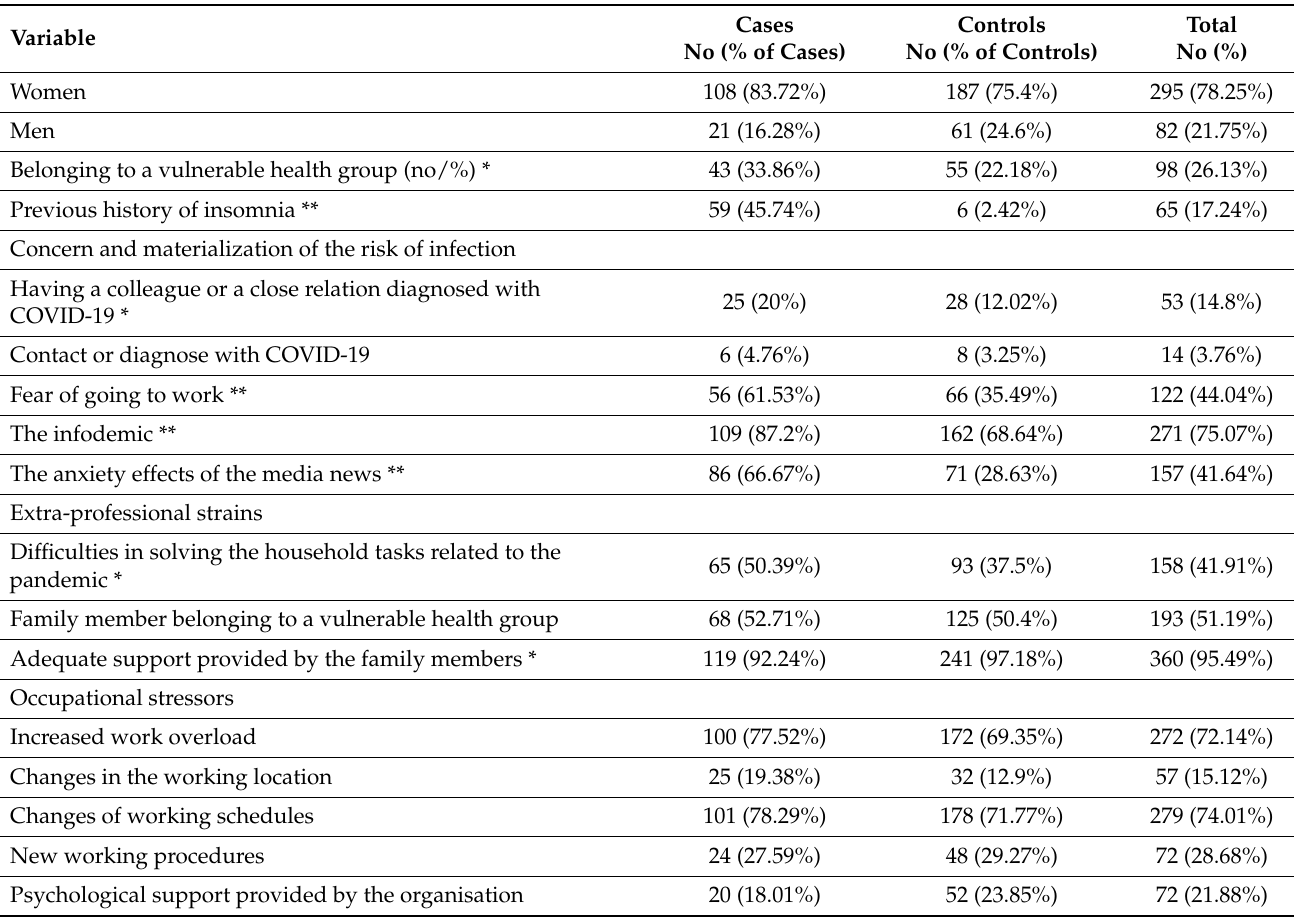
Table 1. Description of the main characteristics of the groups.